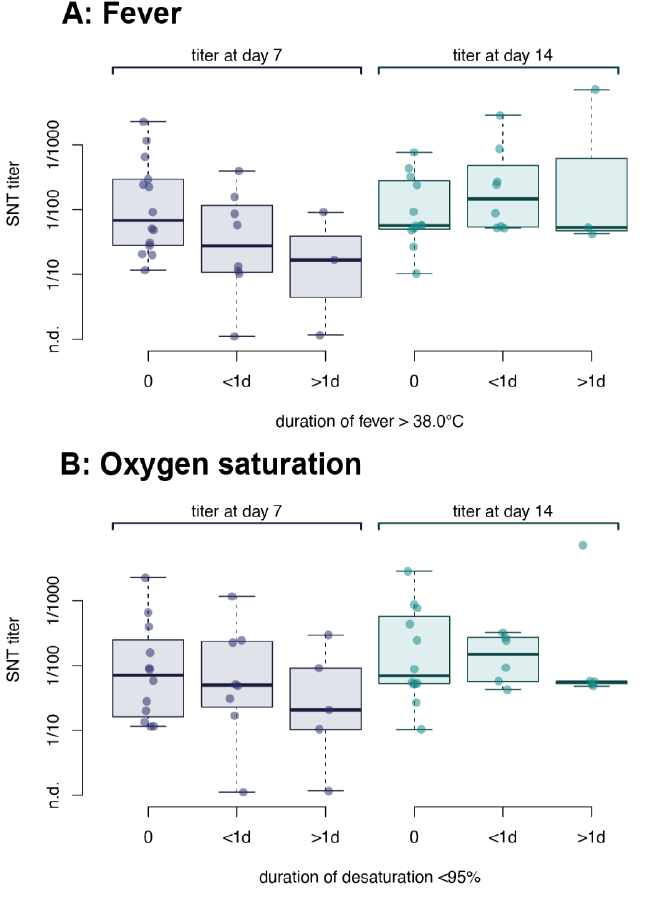
Figure 4. Correlation of the severity of COVID-19 with the antibody response in young adults. Neutralizing antibody titers were correlated with ( A ) tympanic temperature and ( B ) oxygen saturation of symptomatic patients. Patients were grouped according to fever: no fever (never > 38.0 °C), fever < 24 h or fever ≥ 24 h or according to oxygen saturation: no desaturation (never < 95% spO 2 ), <24 h desaturation or ≥ 24 h desaturation. Data were stratified according to the day of sampling relative to the day of diagnosis. No significant differences were observed between the groups by analysis of variance ( p = 0.68 for fever and p = 0.66 for desaturation). n.d. = not detected. 3.5. Common Symptoms of COVID-19 Are Not Related to the Quantitative Serological Response